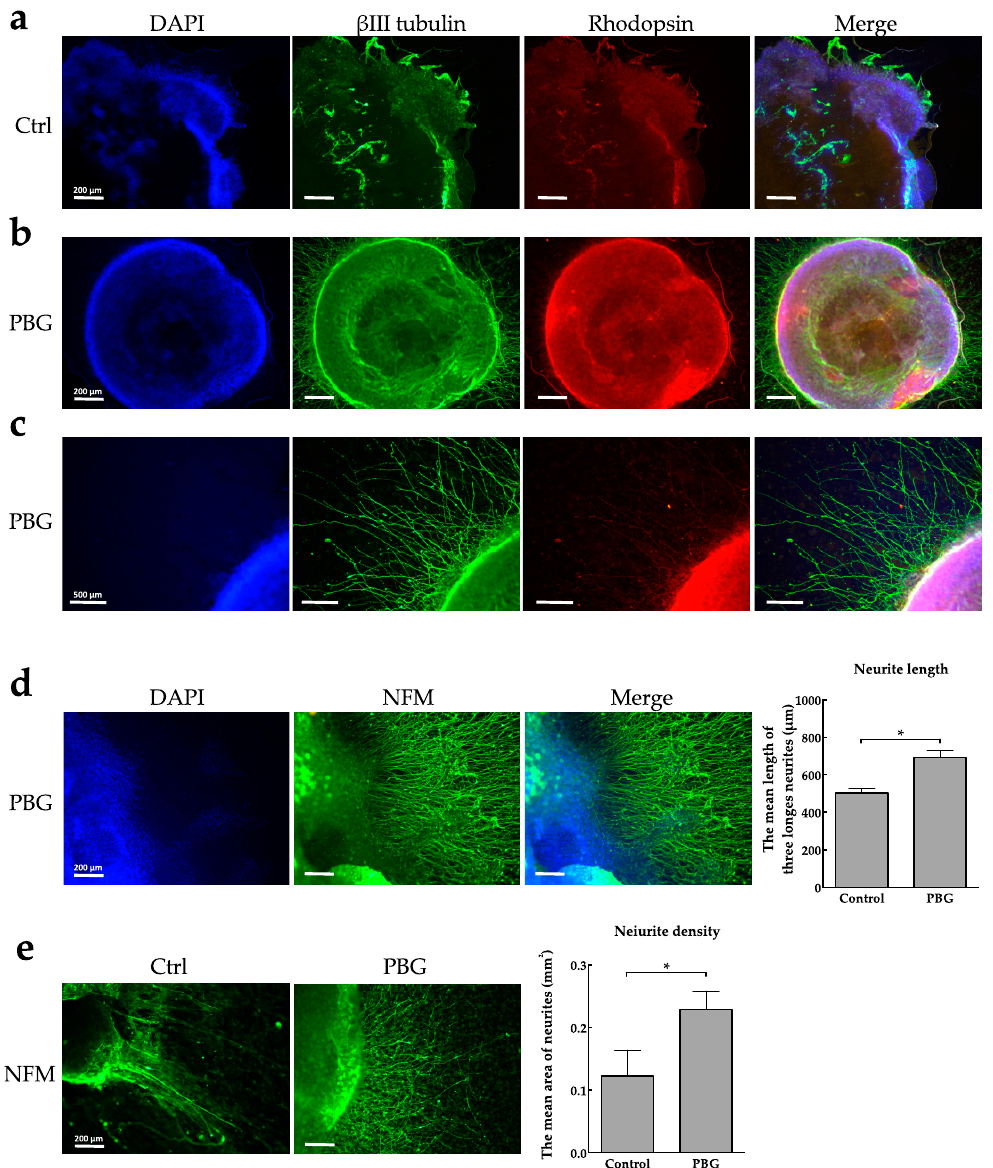
Figure 3. PBG scaffold promotes the differentiation of hiPSC toward RGC-like cells. ( a – c ) Representative images of hiPSC-derived RGC-like cells cultured on cover glass ( a ) and PBG scaffold ( b , c ), and cells were stained with DAPI and anti- β III tubulin and anti-rhodopsin antibody. ( d ) The neurites of hiPSC-derived RGC-like cells were labeled by immunofluorescence with anti-NFM antibody, and the neurite length of hiPSC-derived RGC-like cells cultured on the cover glass or PBG scaffold on Day 34 was measured in the right panel. Values are presented as mean ± SEM, n = 9, * p < 0.05. ( e ) The neurites of hiPSC-derived RGC-like cells were labeled by immunofluorescence with anti-NFM antibody, and the neurite density of hiPSC-derived RGC-like cells cultured on the cover glass or PBG scaffold on Day 34 was measured in the right panel. Scale bars = 200 or 500 μ m. Values are presented as mean ± SEM, n = 3, * p < 0.05.